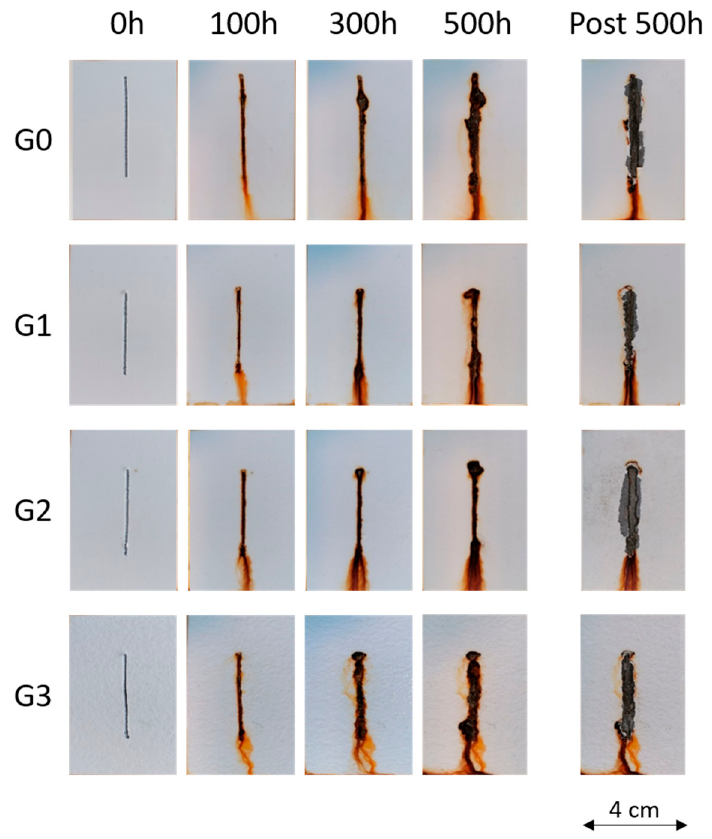
Figure 8. Coatings degradation during the exposure in the salt spray